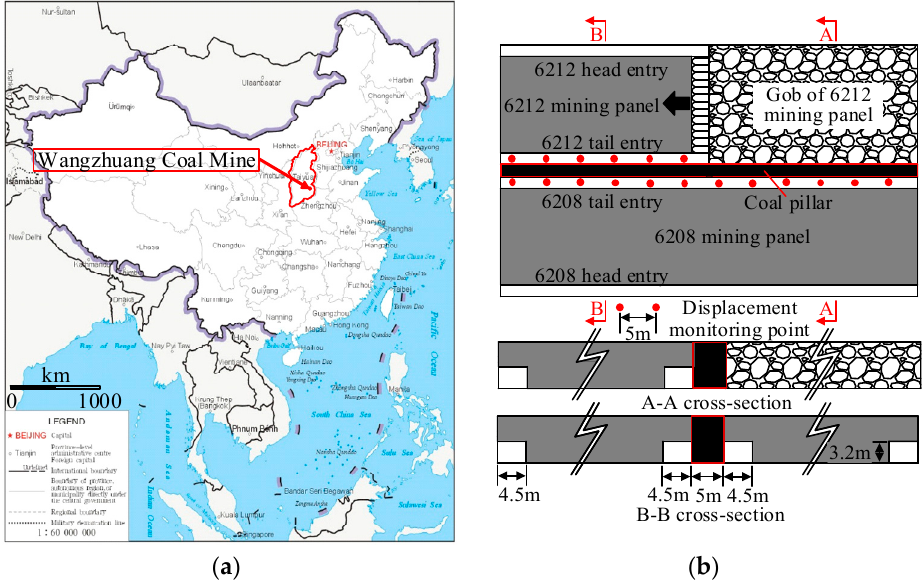
Figure 2. Mine location and panel layout of the study site: ( a ) mine location; ( b ) panel layout of the study site.